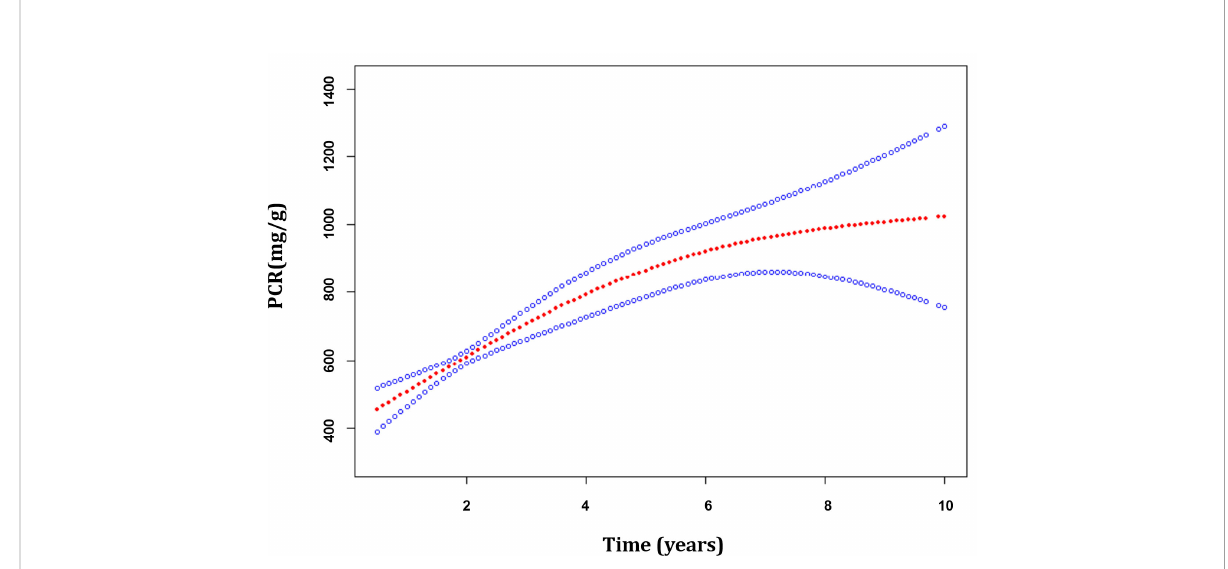
FIGURE 3 The trajectories of the proteinuria/creatinine ratio in patients with immunoglobulin A nephropathy. Estimates were made from mixed-effect models adjusted for age, gender, MEST-C score, mean arterial pressure, estimated glomerular fi ltration rate, body mass index and treatments. The red line indicates the estimated value of the proteinuria/creatinine ratio, and the blue line represents the 95% con fi dence interval for the mean.